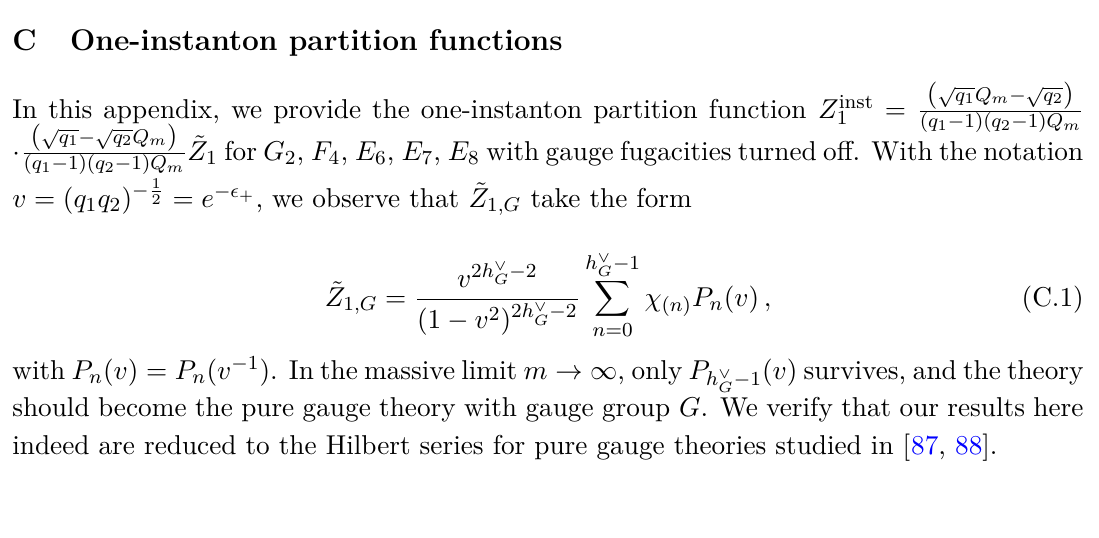
Table 13 . Elliptic genera of ( C 1 ) π and ( C 2 ) π . Here, A z = A z (2 τ ) , b A z = A z (4 τ ) , and same for B z . And E 2 , 2 = E (2) ( τ ) , E 2 , 4 = E (4) ( τ ) . (The definition of I ( τ, (cid:15) 1 , (cid:15) 2 ) can be found in section 2 2